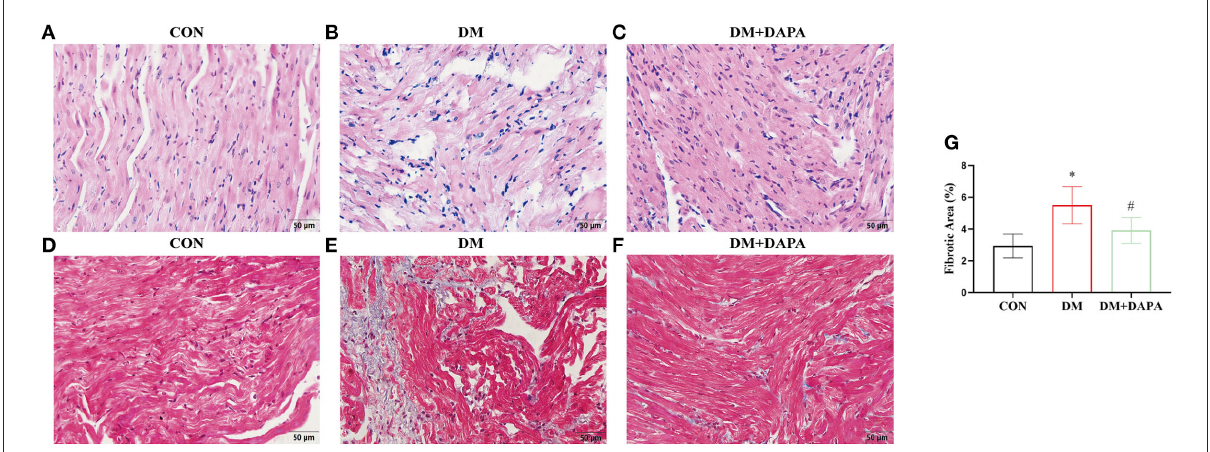
FIGURE2 DAPA alleviates atrial remodeling in diabetic rats. (A—C) Typical images of H&E staining (n = 5); (D–F) representative pictures of Masson staining; (G) statistical analysis of Masson staining (n = 8). (A,D) CON group; (B,E) DM group; (C,F) DM + DAPA group; CON, control group; DM, diabetes group; DM + DAPA, diabetes + dapagliflozin group. Data are expressed as the mean ± SEM. * P < 0.05 vs. CON group. # P < 0.05 vs. DM group.